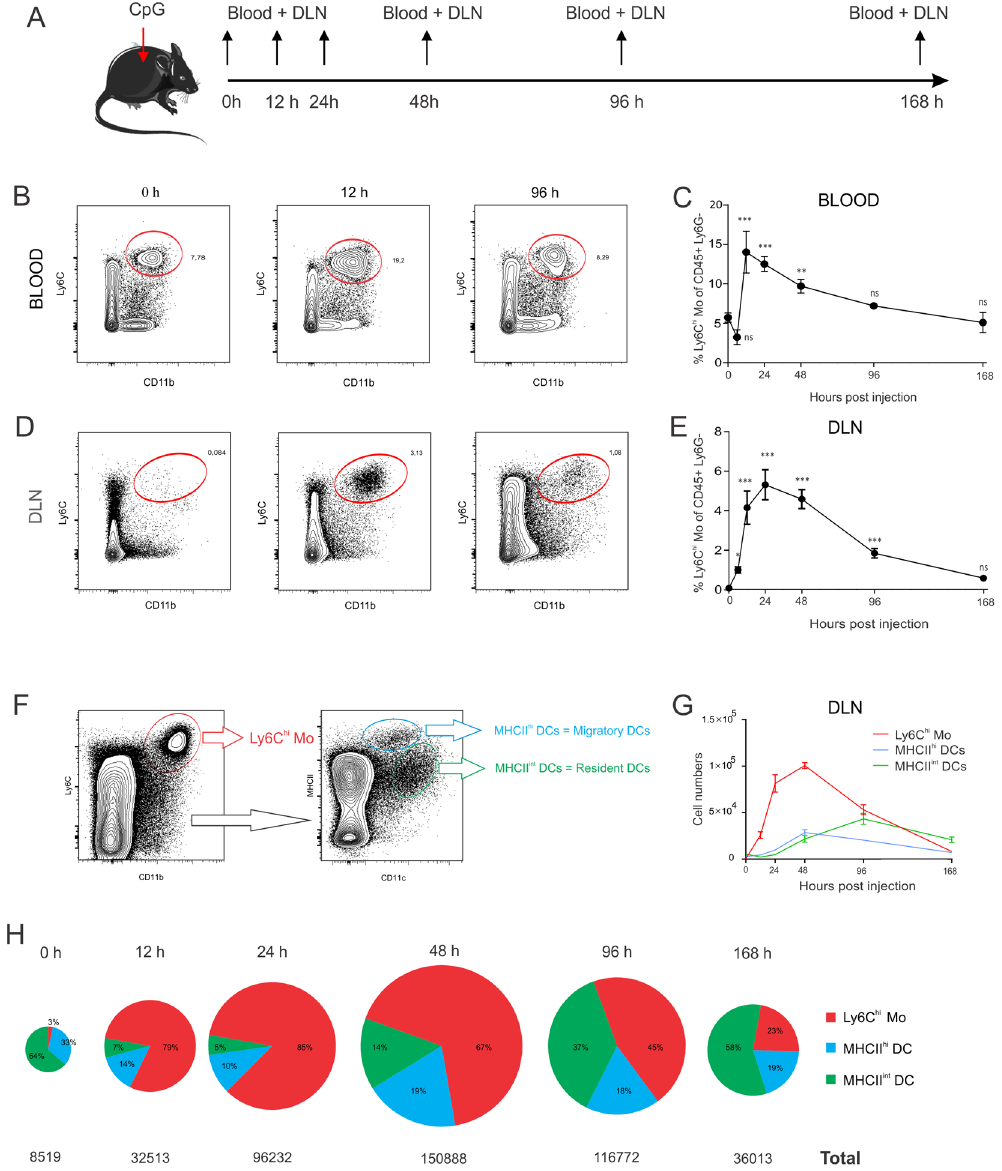
Figure 1. Subcutaneous CpG injection mobilizes Ly6C hi Monocytes and DCs. ( A ) C57Bl/6 mice (n = 4) were injected in the footpad with 20 µ l of CpG (100 µ g/ml) and blood samples and draining popliteal lymph nodes were analysed at the indicated time intervals by flow cytometry. ( B , D ) Flow cytometry plots showing the frequency of Ly6C hi Monocytes in blood ( B ) and draining lymph node ( D ) of CpG injected mice at 0 h, 12 h and 96 h post CpG injection. ( C , E ) Graph showing the frequency of Ly6C hi monocytes in blood ( C ) and draining lymph nodes ( E ) of CpG injected mice (as percentage of CD45 + Ly6G − leukocytes) over time. Mean values at each time interval where compared to mean values at steady state (0 h) *** P < 0.001, ** p < 0.01, * p < 0.05. ( F ) Gating strategy applied to identify migratory DCs and resident DCs in popliteal lymph nodes. ( G ) Graph showing the absolute numbers of Ly6C hi monocytes, migratory DCs and resident DCs in the draining lymph nodes of OVA/CpG injected lice at the indicated time intervals (n = 4; mean + / − SD). ( H ) Pie charts depicting the relative proportions of Ly6C hi monocytes, migratory DCs and resident DCs in the draining lymph nodes. The area of the circles displayed is relative to the added counts of Ly6C hi monocytes, migratory DCs and resident DCs at the indicated time intervals. Data shown are representative of three independent